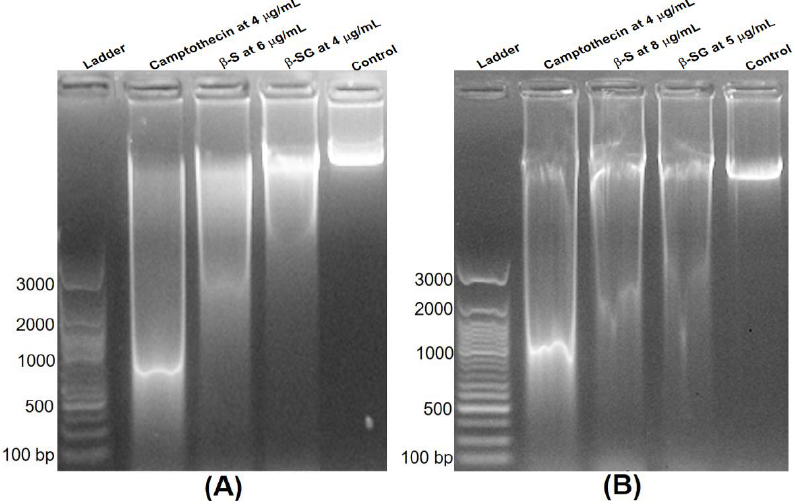
Figure 6. Apoptosis induced in HepG2 ( A ) and Huh7 ( B ) cells by β-S and β-SG at their IC 50 .